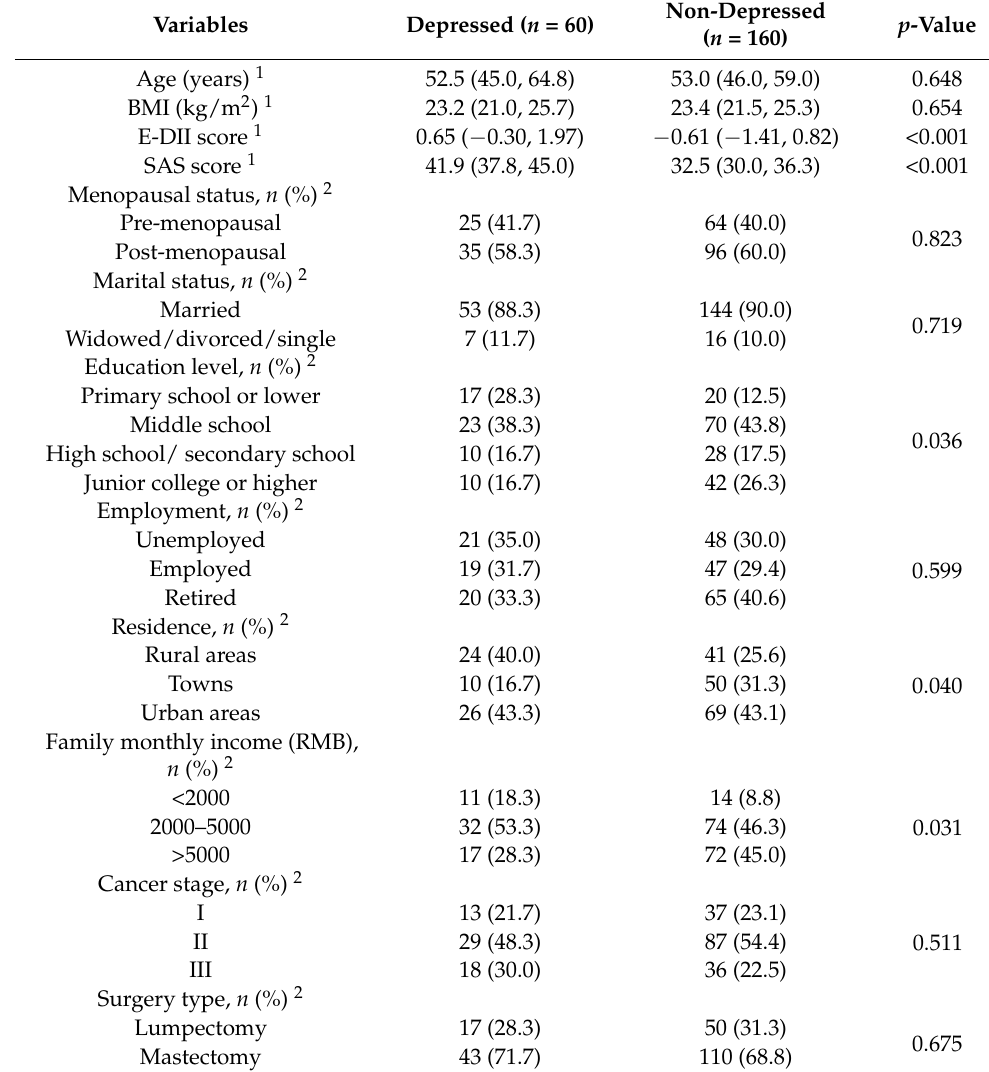
Table 1. Characteristics of the depressed and non-depressed breast cancer